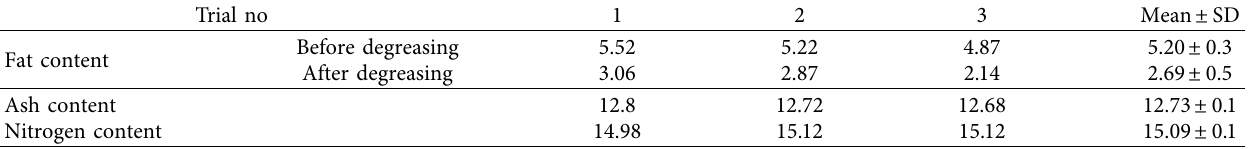
Table 2: Fat and ash content of raw and treated sheep hair waste.